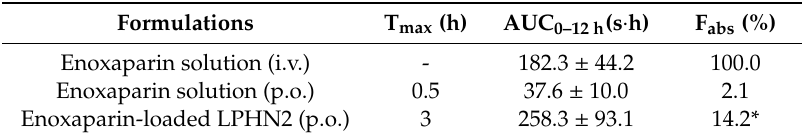
Table 2. Main pharmacokinetic parameters after peroral administration of enoxaparin formulations in rats at a dosage of 1010 IU / kg ( n = 4). * p < 0.05 represents a significant improvement in absolute bioavailability in comparison with enoxaparin solution